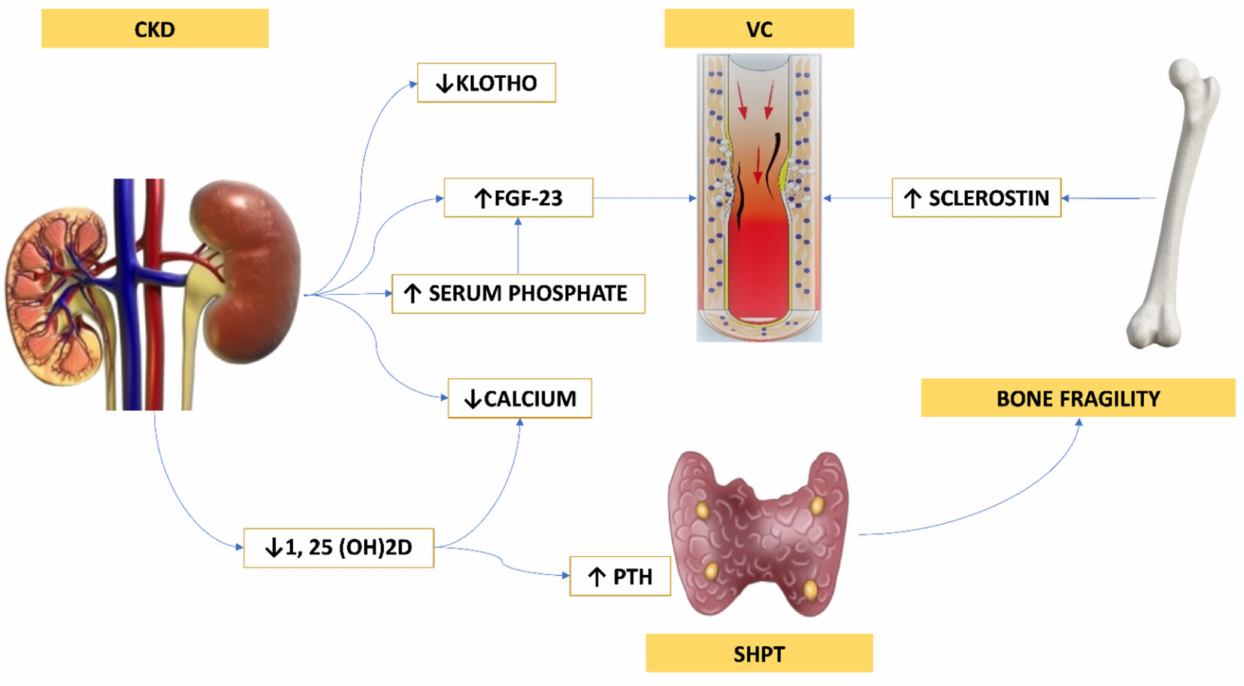
Figure 1. Complex interplay between kidney, parathyroid glands, bone and cardiovascular system in CKD-MBD pathogenesis. CKD is characterized by a secondary hyperparathyroidism: the progressive reduction of GFR leads to an increase of serum phosphate levels, a progressive hypocalcemia, and augmented FGF-23 production. Meanwhile, the reduced activity of the enzyme 1 alpha-hydroxylase induces a decrease of 1,25-dihydroxyvitamin D, further determining a PTH rising. High serum phosphate and FGF-23 levels also stimulate an increase of sclerostin production by osteocytes. Sclerostin and FGF-23 are involved in the progression of VC. Abbreviations: CKD = Chronic Kidney Disease; FGF-23 = fibroblast growth factor 23; 1, 25 (OH)2D = 1,25-dihydroxy-vitamin D; PTH = parathyroid hormone; SHPT = Secondary hyperparathyroidism; VC = Vascular Calcification